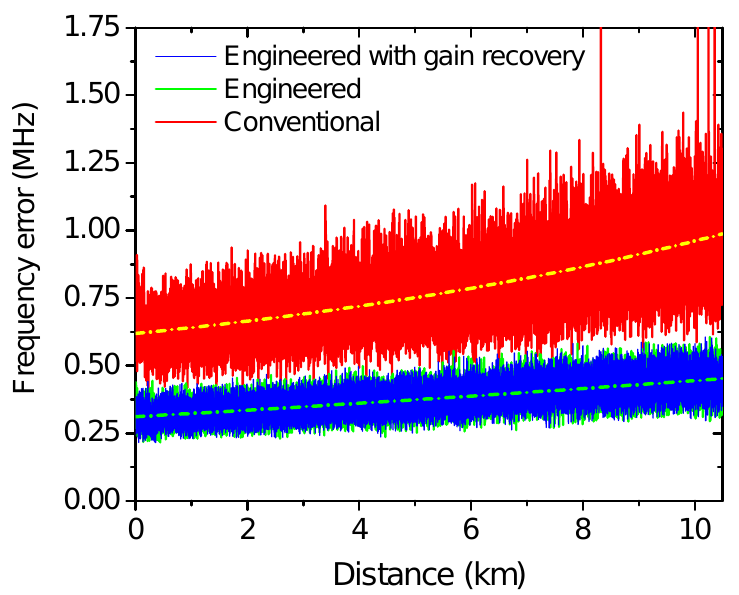
Figure 6. The frequency error distribution measured by the conventional (red) and engineered BGS with (green) and without (blue) gain